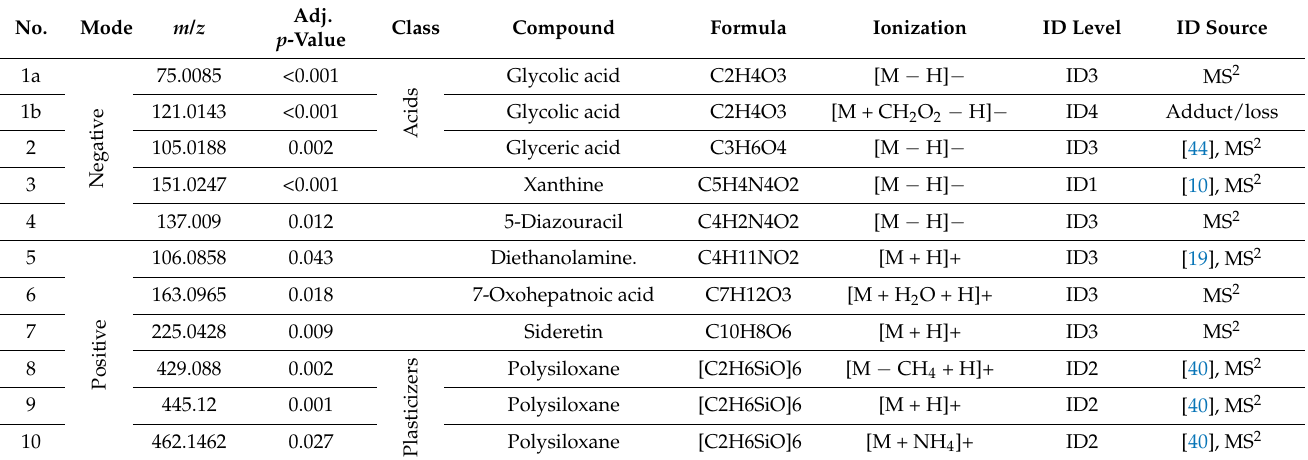
Table 2. Compounds that were putatively identified and elevated in the CF group. Adj. = adjusted, Lit. = literature, ID = identification Reproduced with permission of the © ERS 2022